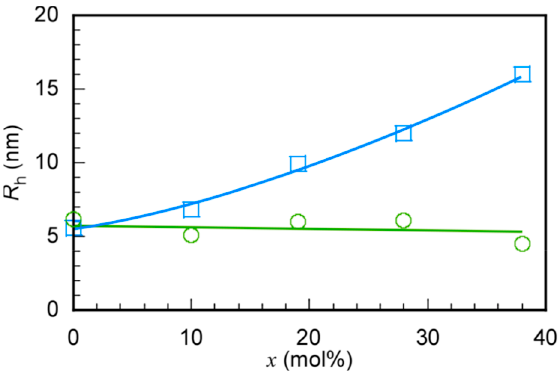
Figure 6. Hydrodynamic radius ( R h ) of P(MPC/DMA x ) in 0.1 M NaCl aqueous solutions ( □ ) and in methanol ( 〇 ) as a function of the DMA content in the copolymer ( x ).